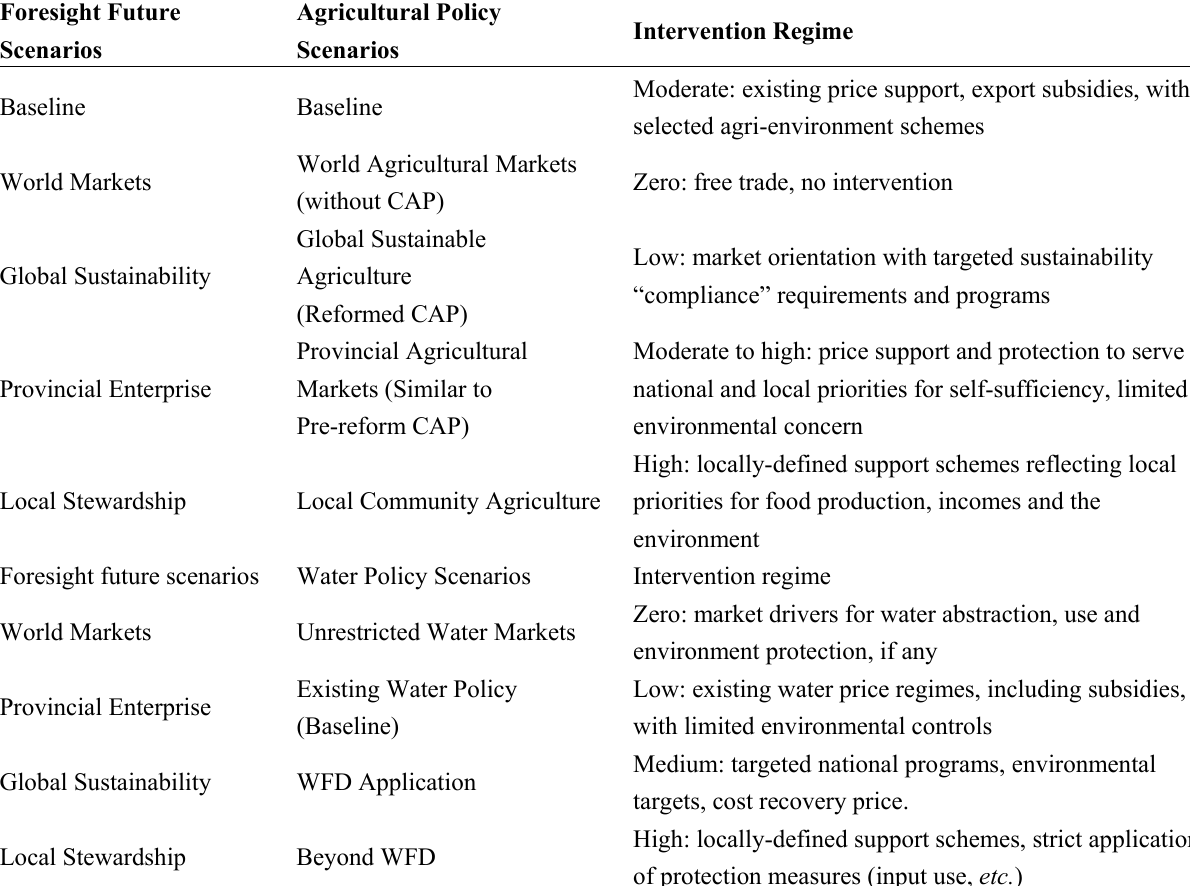
Table 11. Links between Foresight and agricultural future scenarios [17]. CAP, Common Agricultural Policy; WFD, Water Framework